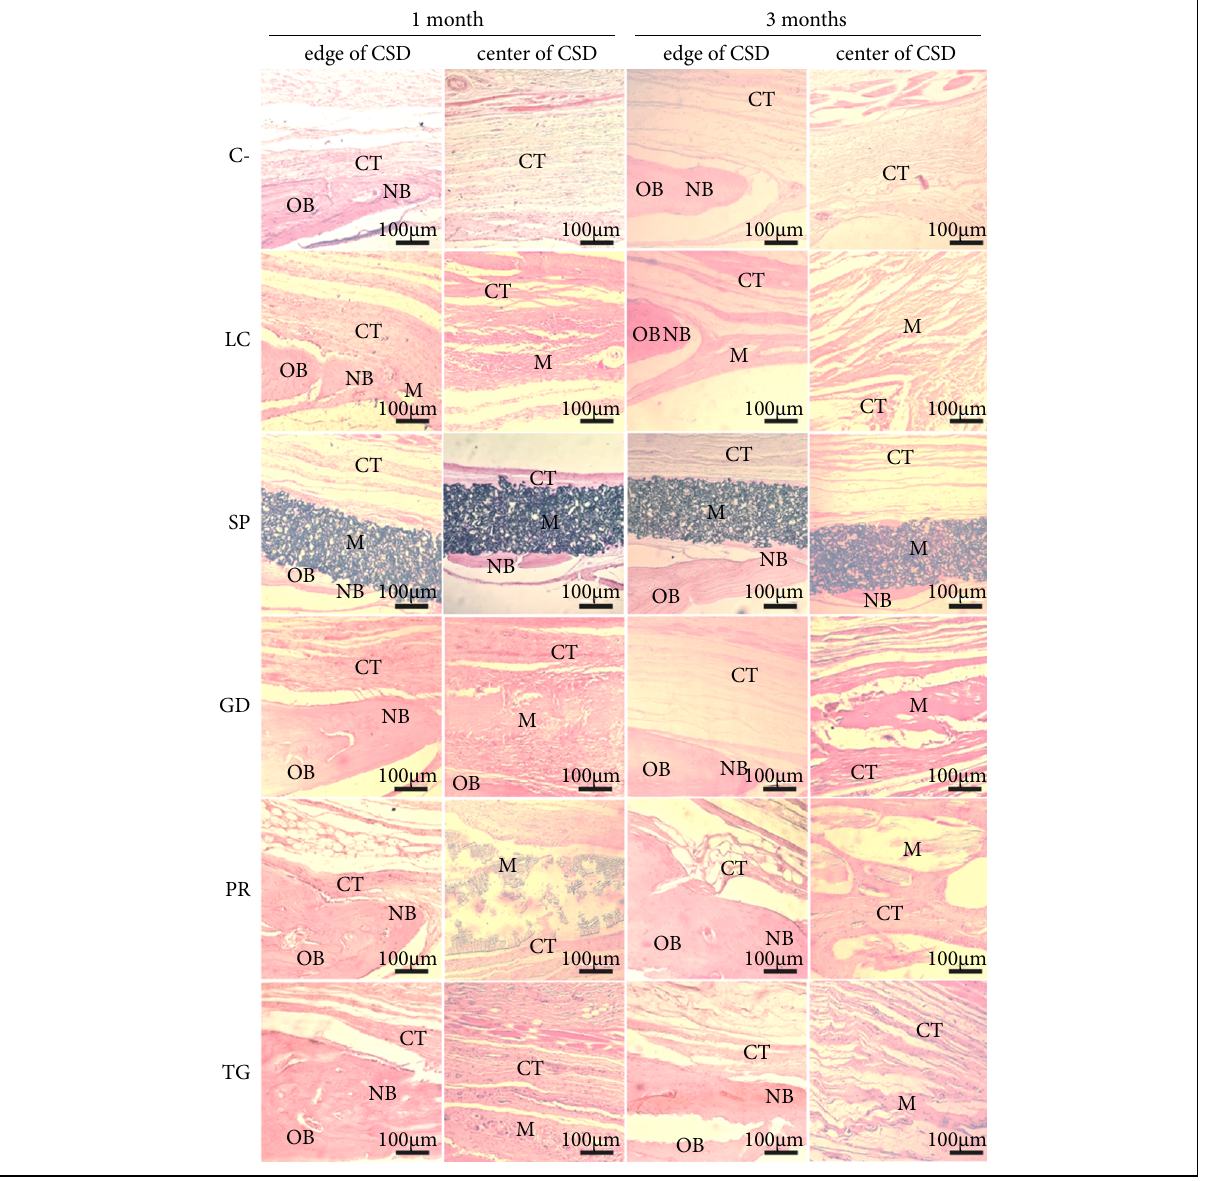
Figure 2 – Histological analysis in critical size bone defects (CSD) in rat calvaria for the different experimental groups at one and three months. Qualitative data of control (C-), LuminaCoat (LC), Surgitime PTFE (SP), GenDerm (GD), Pratix (PR) and TechGraft (TG). All groups exhibited the most prominent presence of new bone (NB) at the edge of the CSD, adjacent to native old bone (OB), while at the center of the CSD there were varying amounts of connective tissue (CT) and/or residual membrane